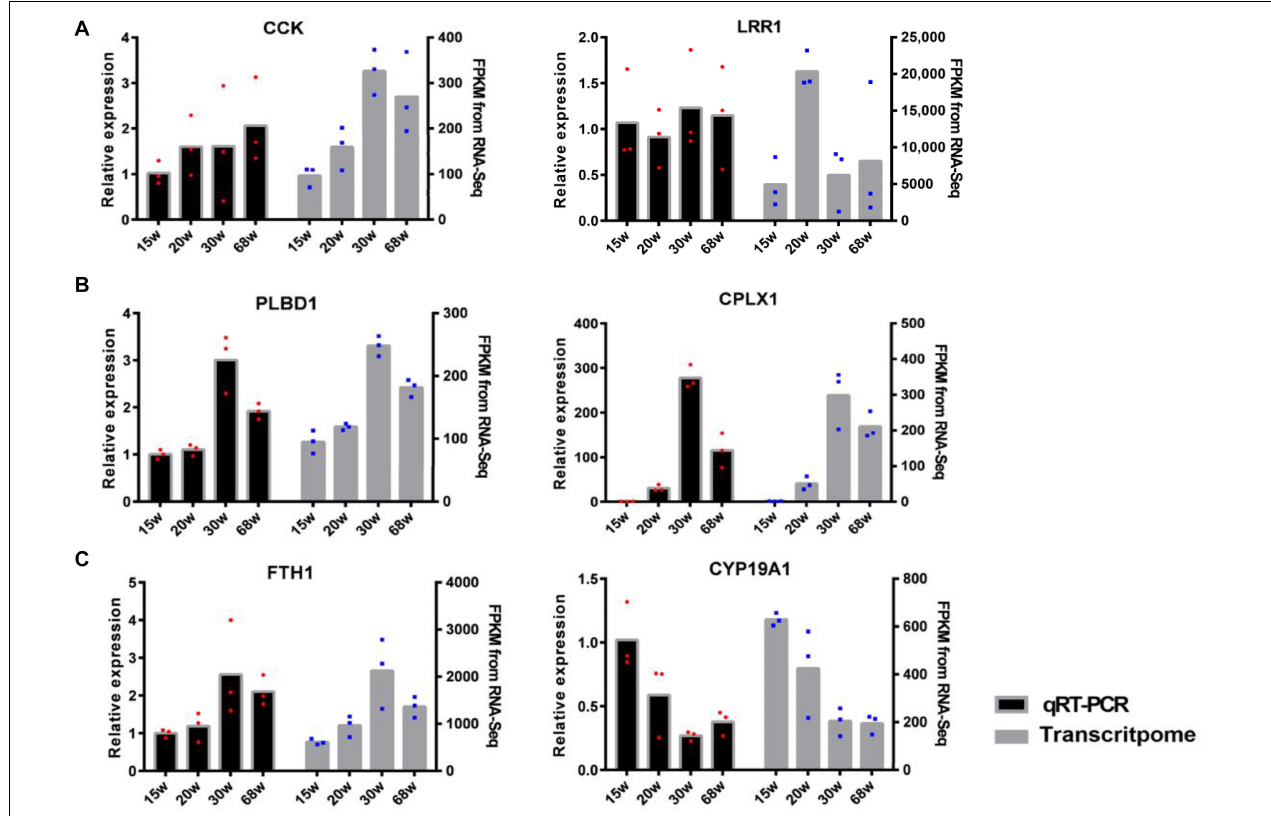
FIGURE 7 | The validation of differentially expressed mRNAs between qRT-PCR and transcriptome analysis [ (A) hypothalamic, (B) pituitary, and (C) ovary]. The left hand y -axis shows the value of relative expression, the right hand y -axis shows the value of FPKM. The dots with red and blue correspond to the three biological